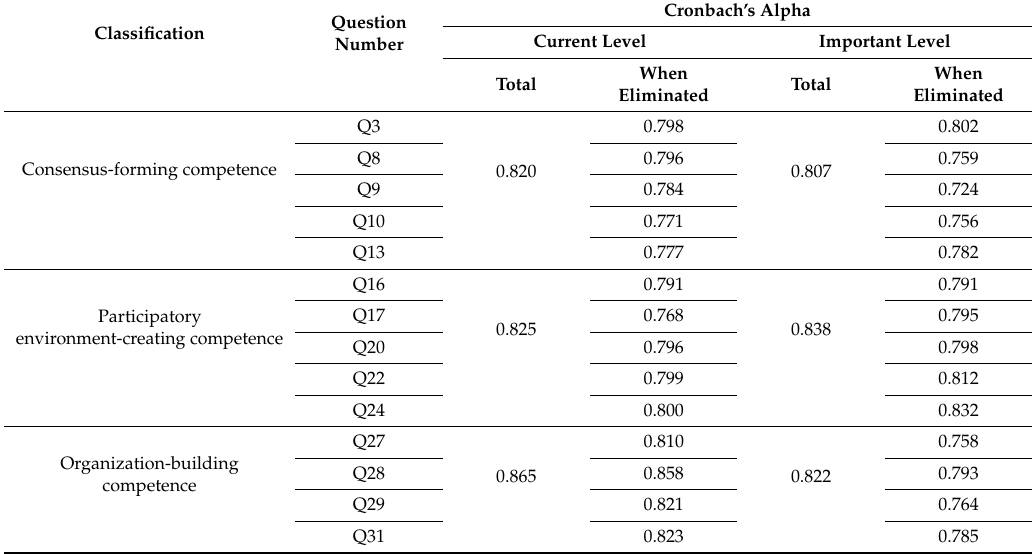
Table 4. Reliability